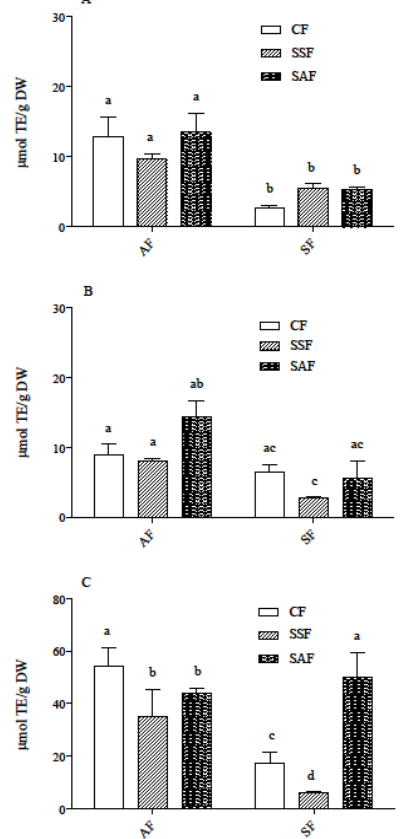
Figure 4. ORAC of extracts containing FREE ( A ), SC ( B ), and IB ( C ) phenolic acid fractions of bread samples. AF and SF breads were prepared by CF or SSF or SAF as the starter flour. Results are expressed as µmol TE/g DW and are the mean ± SD of two independent experiments with duplicate samples. Different letters indicate significant differences at p < 0.05. AF = ancient flour; SF = standard flour; CF = conventional fermentation; SAF = sourdough obtained from ancient flour; SSF = sourdough obtained from standard flour.